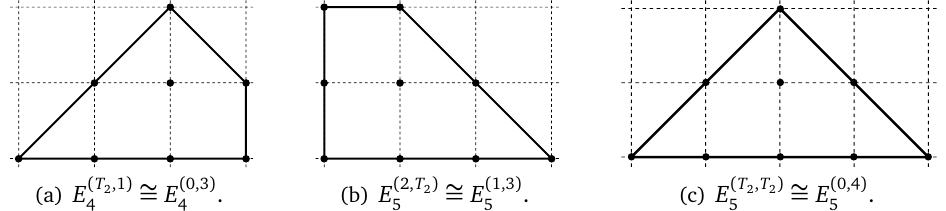
Figure 27: The T “rank-zero” toric geometry, and the T 2 3 and 30 allowed vertical resolutions, respectively.